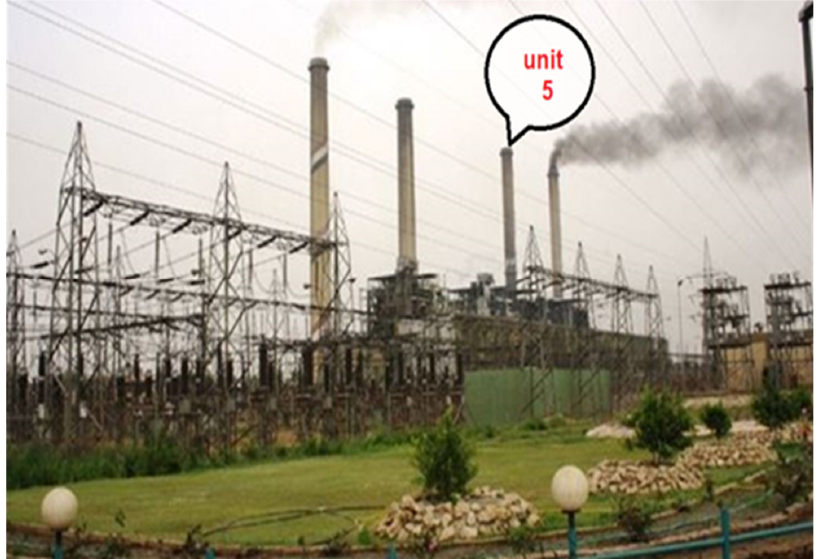
Fig. 1. Al- Doura Power Station.